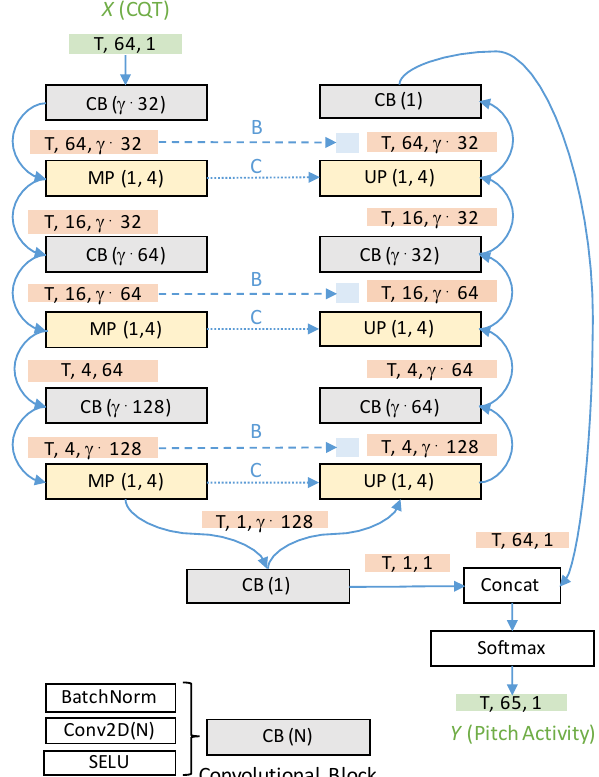
Figure 2. U-net network architecture includes a decoder (left column) and an encoder (right column) with a sequence of convolutional blocks (CB), max pooling layers (MP), and unpooling layers (UP). Input and output variable dimensions are shown in green. Intermediate tensor dimensions are shown in orange. Solid blue lines show layer connections. Dashed and dotted blue lines indicate different skip connection strategies (compare Section 3.4). Number of kernels in the convolutional layers can be scaled with a factor γ (compare Section